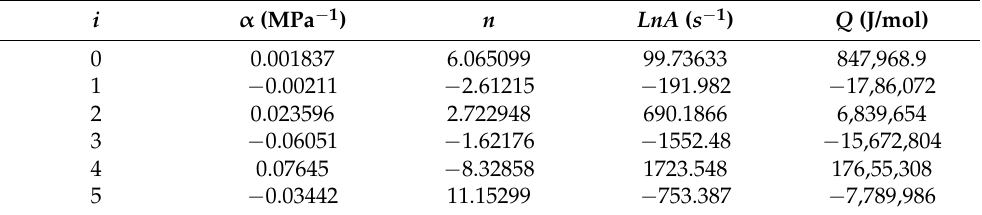
Table 4. The material parameters of TA31 for Arrhenius-type model by optimization method.